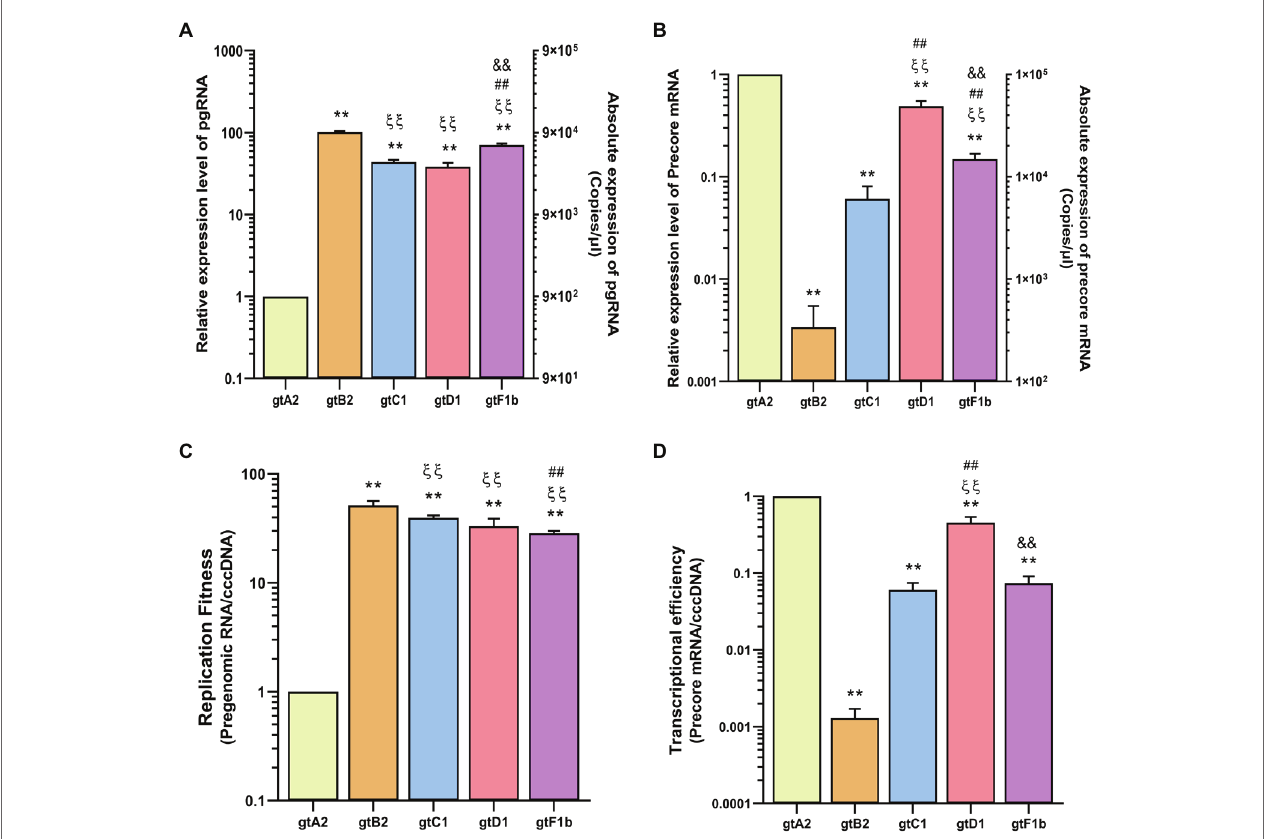
FIGURE 2 | Analysis of HBV RNA levels across genotypes. HuH-7 cells were transfected with linear full-length HBV genomes of genotypes A2, B2, C1, D1, and F1b. Three days post-transfection, cells were harvested, total RNA was extracted, and pgRNA (A) and Precore mRNA (B) levels were analyzed by transcript-specific RT-qPCR. (C) cccDNA replicative activity was determined as molecules of pgRNA synthesized per cccDNA (pgRNA/cccDNA). (D) The number of Precore mRNA transcripts produced per cccDNA (Precore RNA/HBVccc) was used to assess HBV transcriptional efficiency. Values shown represent the mean ± standard deviation of three independent experiments. *: difference in relation to gtA2, ξ: difference in relation to gtB2, #: difference in relation to gtC1 and &: difference in relation to gtD1. Two symbols: p <